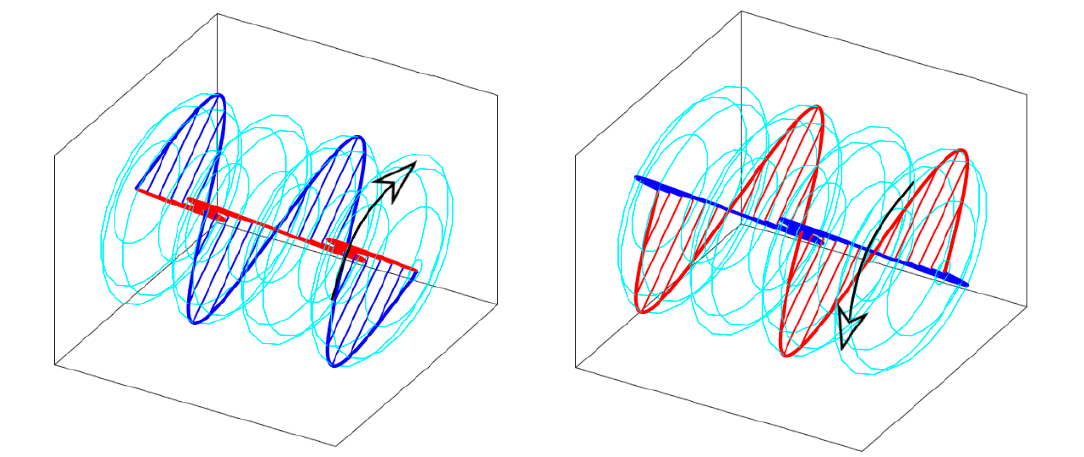
Figure 5. The vibration modes when h = 5Nms.